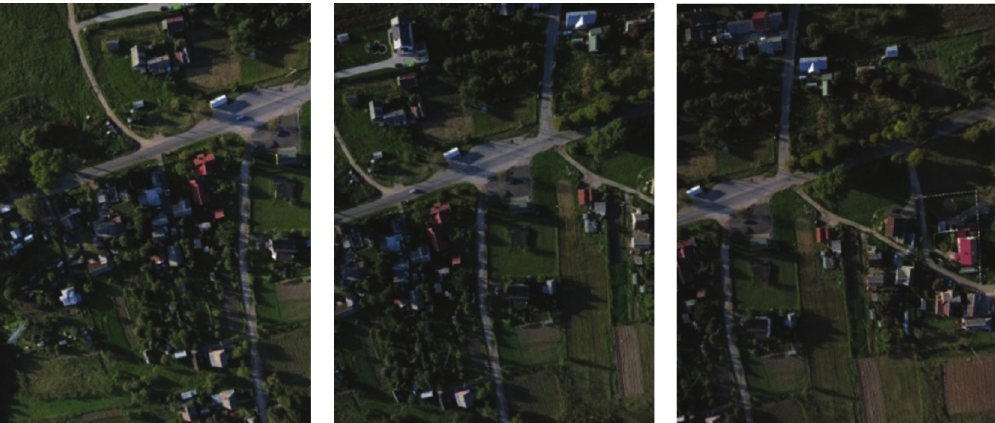
Figure 4: Images IMG 3, 4, 5.